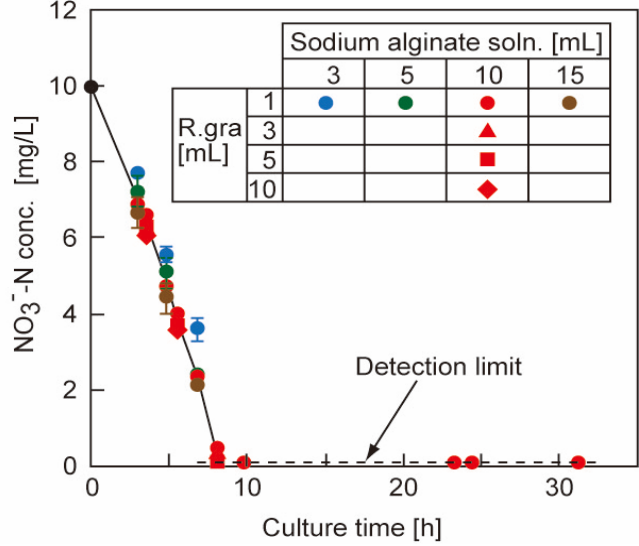
Figure 2. Change in nitrate-nitrogen concentration at various yeast densities in alginate hydrogel bead. The detection limit of nitrate nitrogen by the ion chromatography method is 0.2 mg/L: Red symbols, Volume of R. gra suspension was varied from 1, 3, 5, and 10 mL to 1 mL of sodium alginate of 1.5% concentration. Circular symbols, Volume of sodium alginate at a concentration of 1.5% was varied from 3, 5, 10, and 15 mL to 1 mL of R. gra